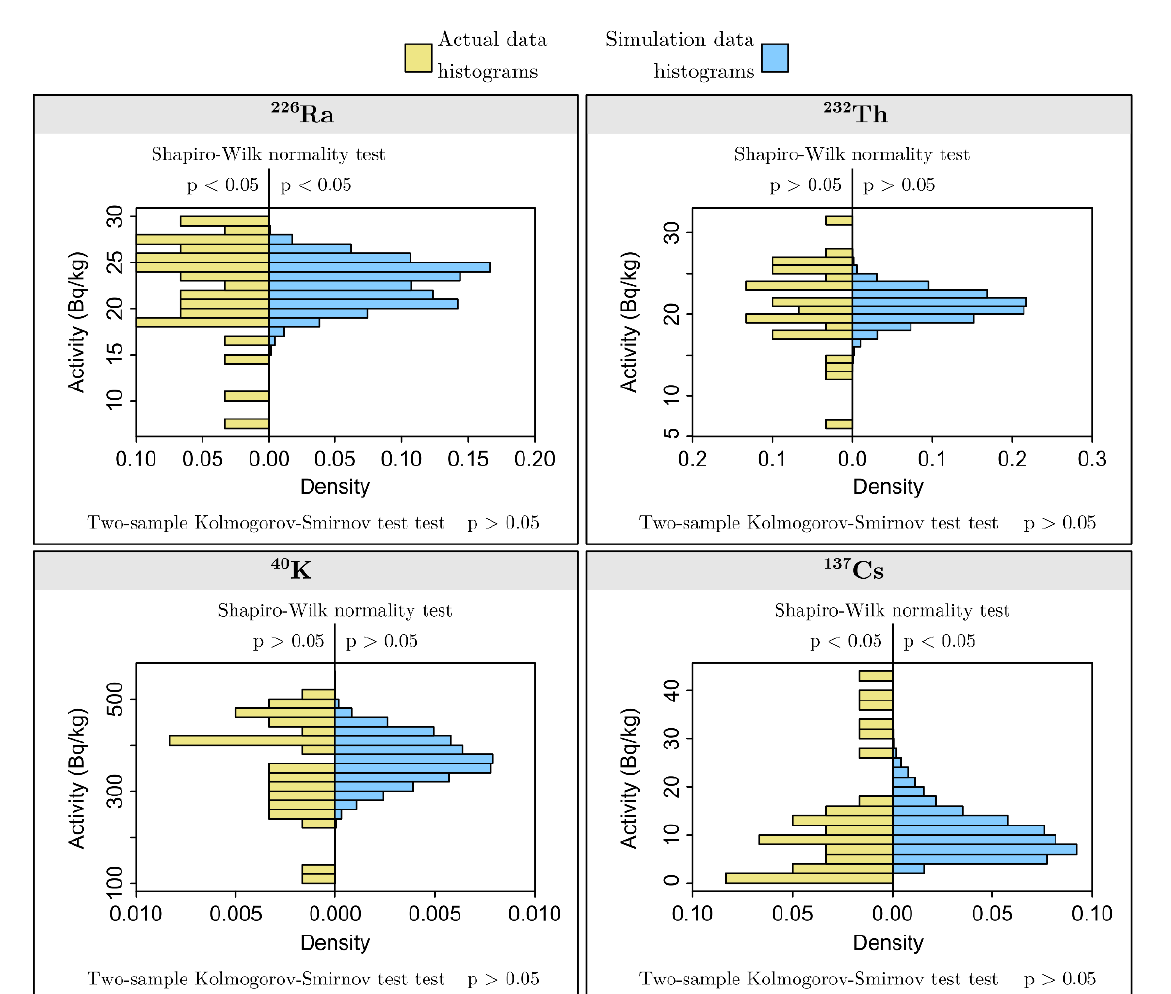
Figure 3. Frequency distributions of 226 Ra, 232 Th, 40 K, and 137 Cs concentrations for actual and simulation data.